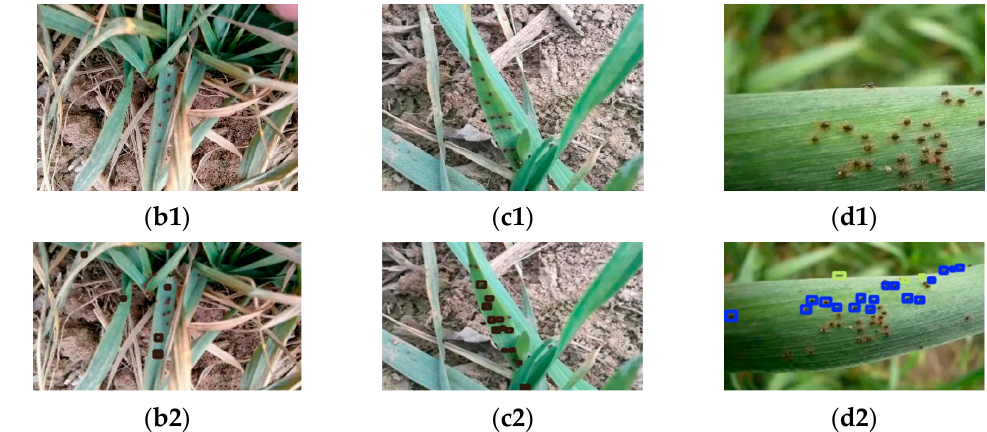
Figure 8. Wheat spider. ( a1 ), ( b1 ), ( c1 ), and ( d1 ) are the original images; ( a2 ), ( b2 ), ( c2 ), and ( d2 ) are the recognition results. the recognition